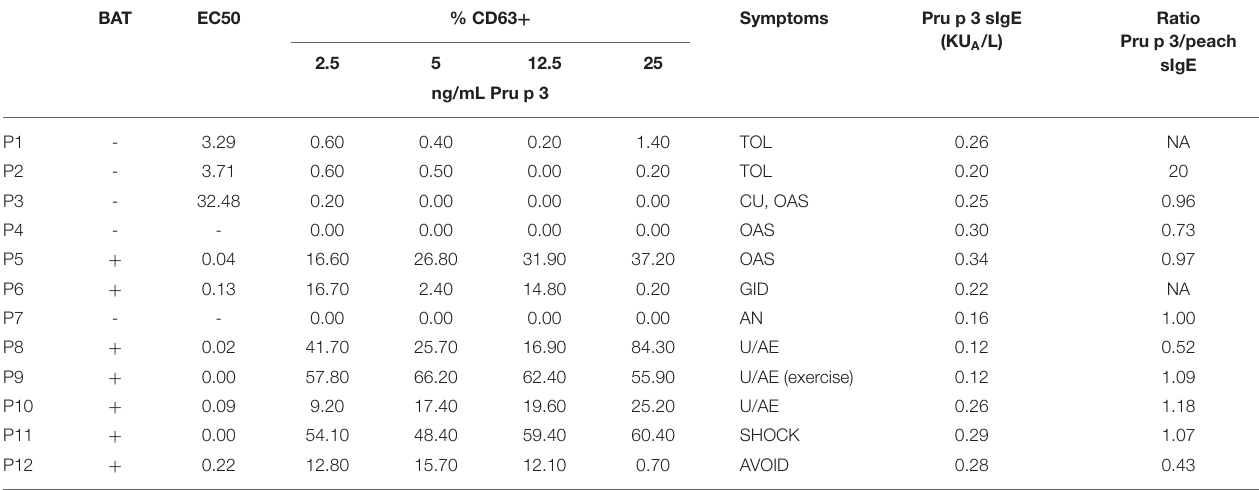
TABLE 3 | Characteristics and BAT results of the allergic patients from grLOW. BAT EC50 % CD63 + Symptoms Pru p 3 sIgE